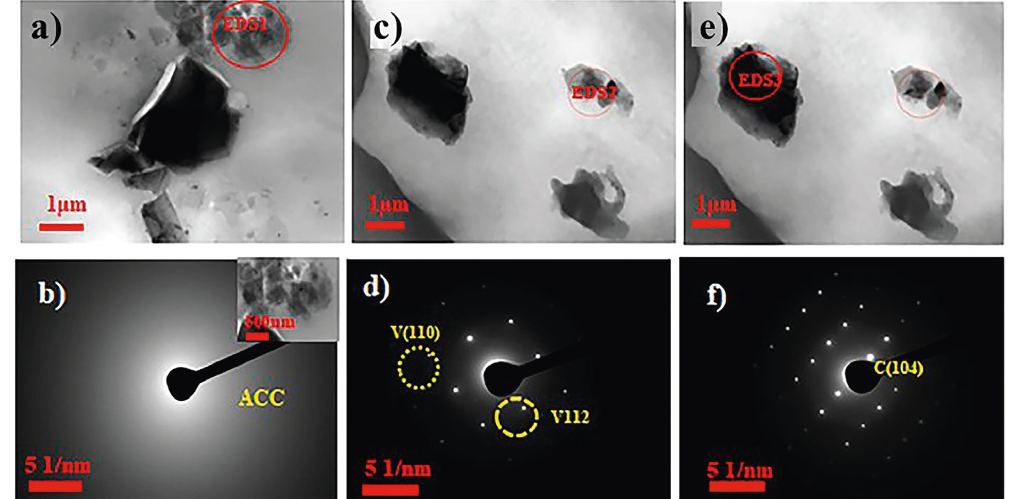
Figure 4: TEM and SAED of (a, b) amorphous calcium carbonate, (c, d) vaterite, and (e, f) calcite obtained from the medium cross-linked of (PAH/PAMAM) 7.5 -CaCO 3 from PVDF-HFP